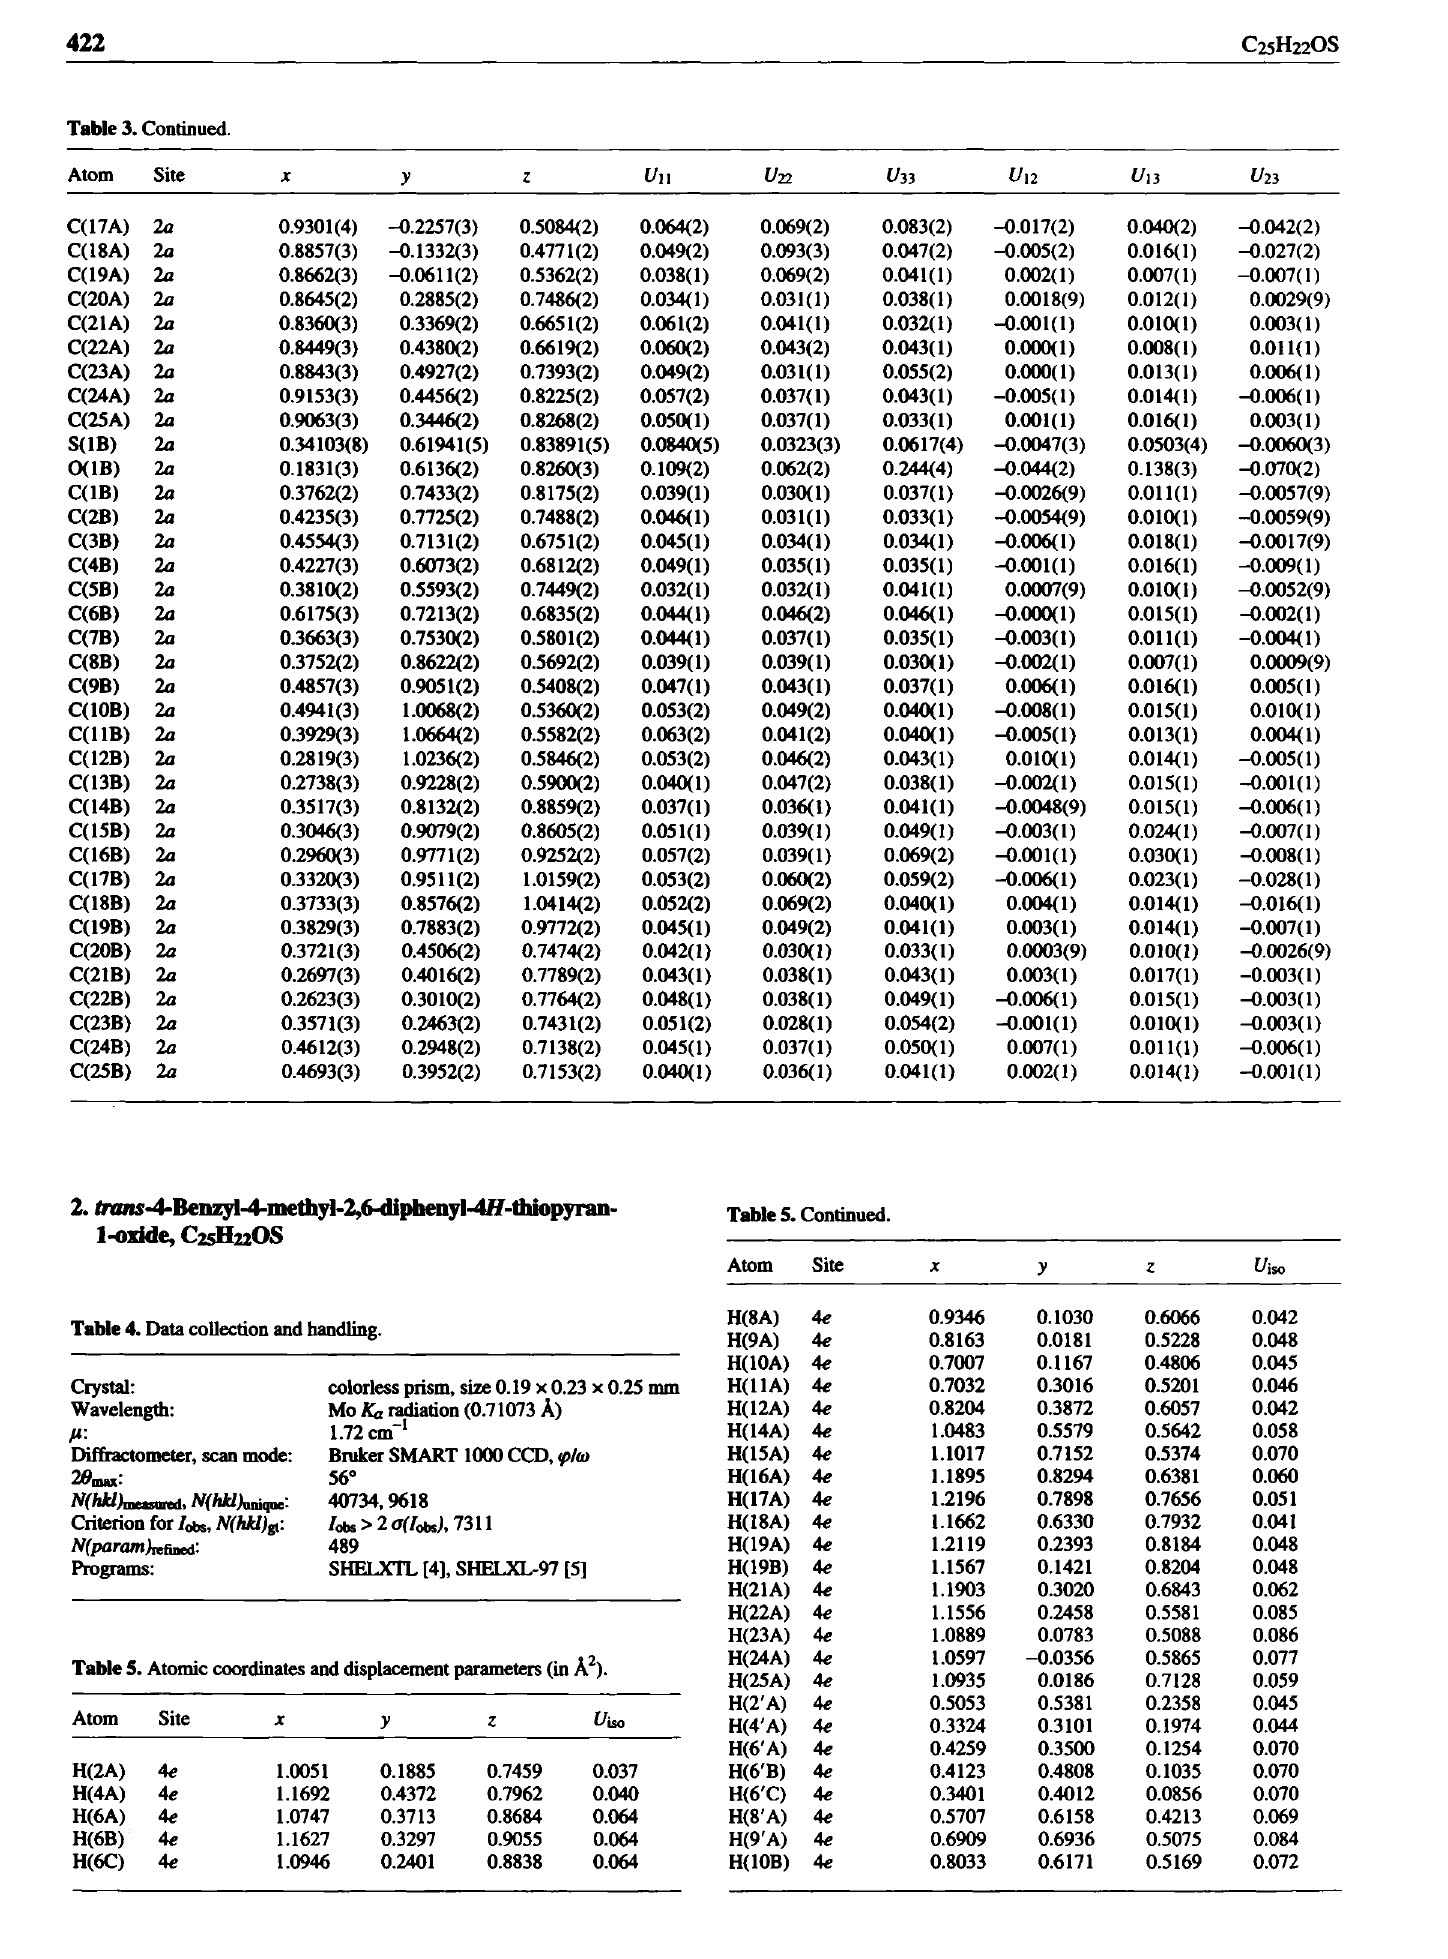
Table 5. Atomic coordinates and displacement parameters (in Ä 2